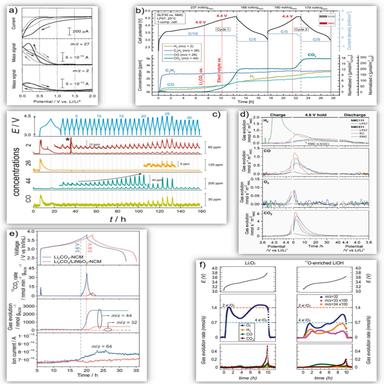
.2. (a) CVs and MSCVs recorded for graphite in LP30 electrolyte (1 M LiPF6 in EC:DMC = 50:50 (v/v)) showing the MS channels m/z = 27 (C2H4, middle) and m/z = 2 (H2, bottom); (b) OEMS data during first two formation cycles of an NMC||graphite full-cell with LP57 electrolyte (1 M LiPF6 in EC:EMC = 30:70 (v/v)) showing evolution of H2 (green), CO (turquoise), C2H4 (blue), and CO2 (dark green) (MS channels m/z = 2, 26, 28, and 44, respectively); (c) Long-term OEMS testing (> 30 cycles) on an NCM52